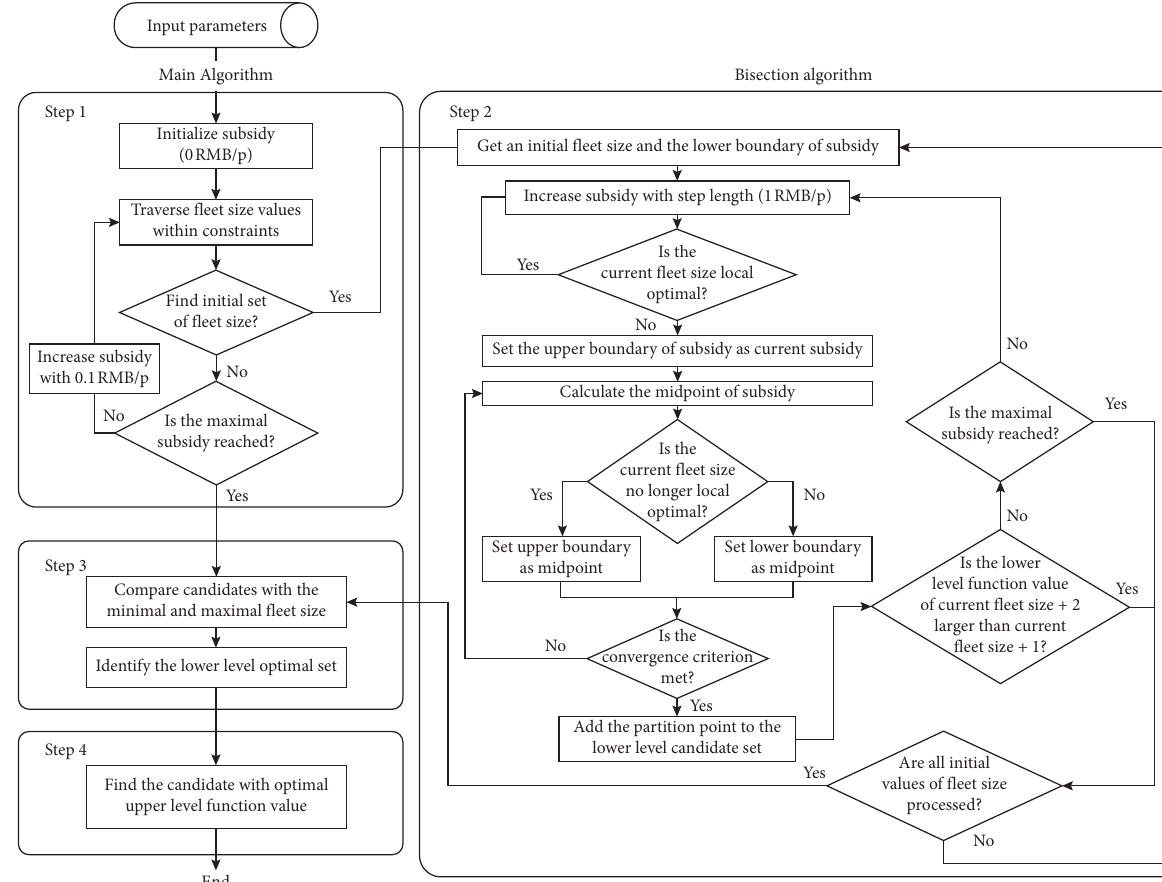
Figure 2: The overall procedure of the proposed partition-based-bisection algorithm.